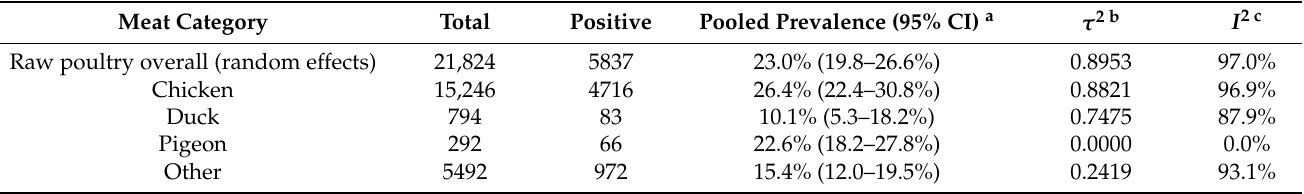
Table 1. Meta-analysis results for mean prevalence of Salmonella in poultry by meat type based on the included reports. Meat Category